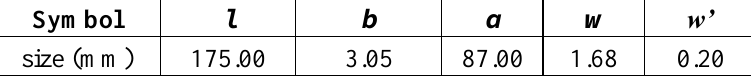
Table 1. Size of dipole and T impedance match